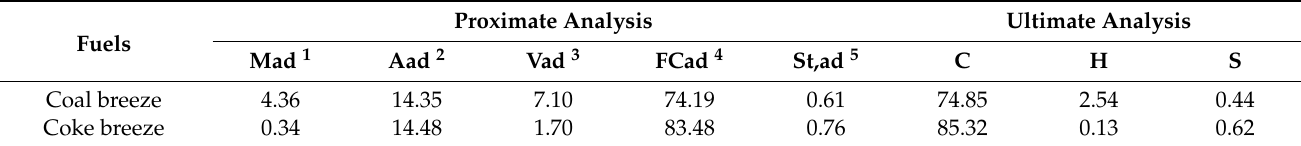
Table 2. Proximate and ultimate analyses of solid fuels (mass fraction, mass